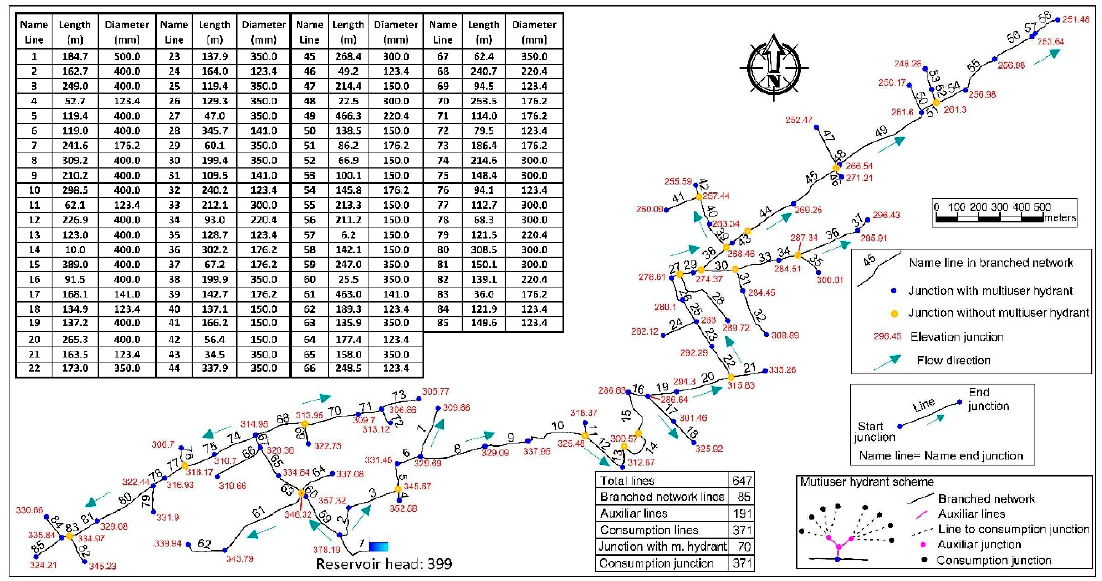
Figure 5. Characteristics and scheme of the water network.